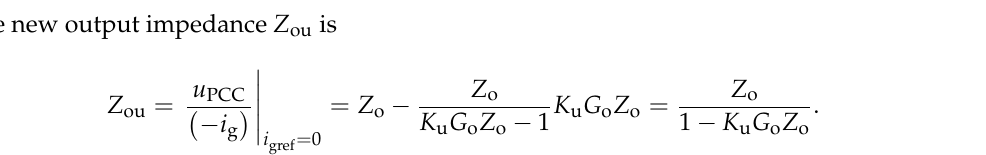
Figure 5. The structure of grid voltage feedback control.